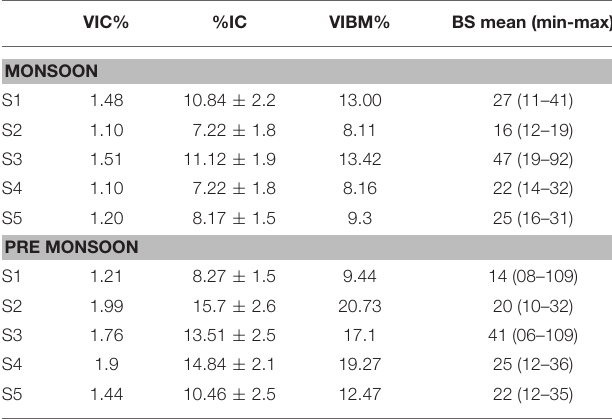
TABLE 2 | Table showing “Viral lytic infection and burst size” estimates by transmission electron microscopy (TEM)